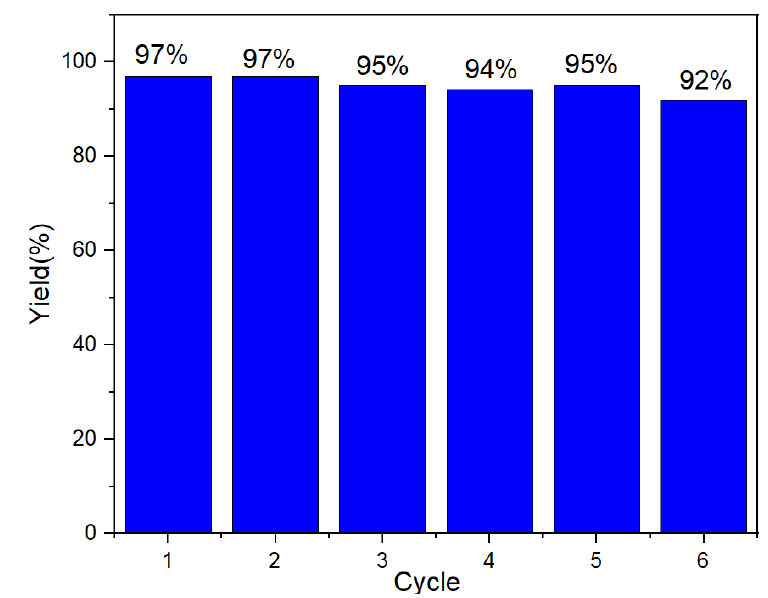
Figure 3. Reuse of CS/PVA/MMT@Pd.